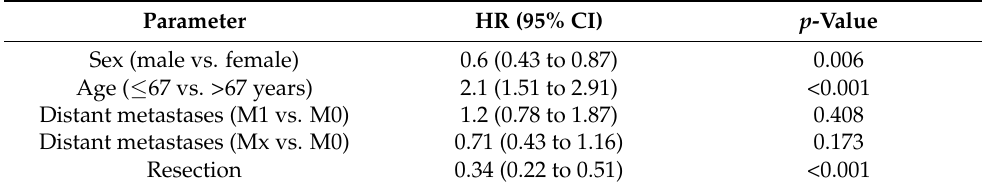
Table 3. Multivariable Cox regression for PACC patients with available survival data ( N =